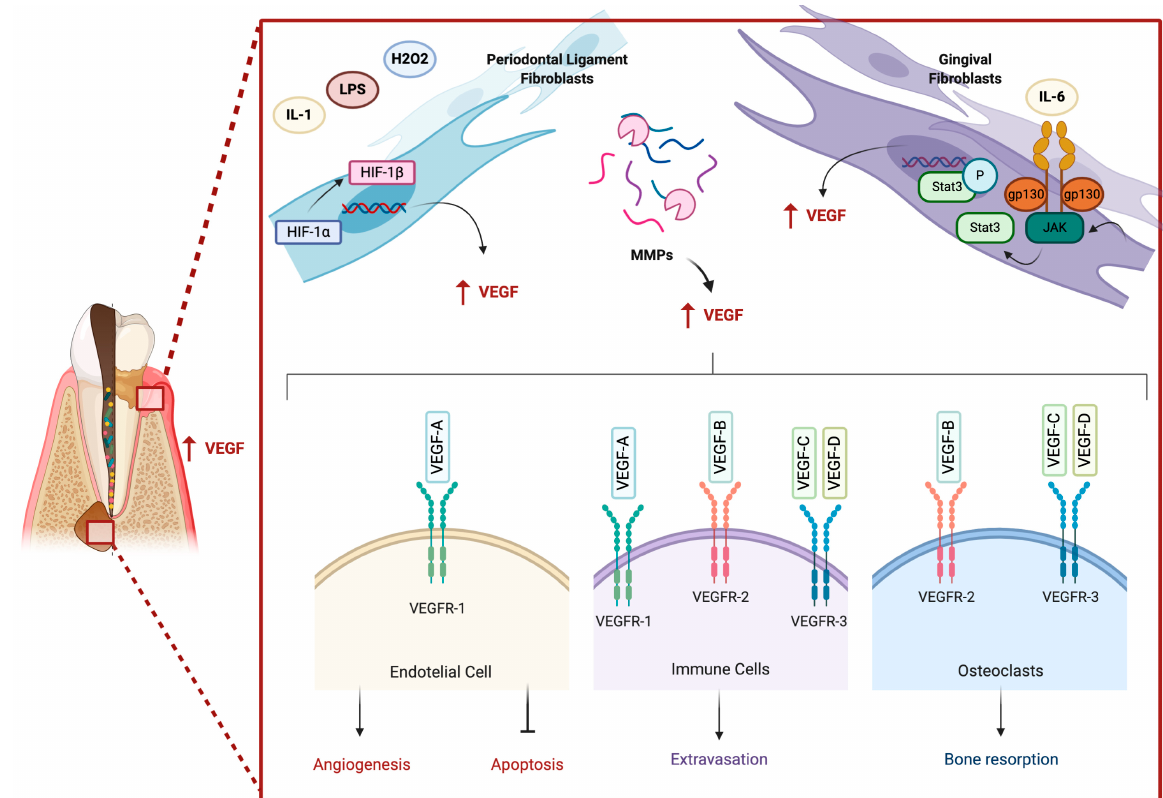
Figure 2. Role of VEGF in inflammatory periodontal diseases. During inflammatory periodontal diseases VEGF transcription can be induced by the activation of two pathways: (1) in periodontal fibroblasts IL-1, LPS and reactive oxygen species (H 2 O 2 ) may induce the transcription of VEGF through the activation of the HIF/VEGF pathway. (2) The formation of the complex IL-6/IL-6R/gp130 may activate JAK/STAT pathway enhancing the secretion of VEGF by gingival fibroblasts. Also, VEGF might be released through the MMP-mediated proteolytic cleavage from its cryptic forms from the extracellular matrix. These cellular pathways might result in the following effects: VEGF in endothelial cells inhibits apoptosis and VEGF-A/VEGFR-1 interaction induces angiogenesis in immune cells, VEGFs participates in leukocytes’ extravasation and in osteoclasts VEGFR ‐ 2/ ‐ 3 are associated with alveolar bone resorption. Created with Biorender.com.